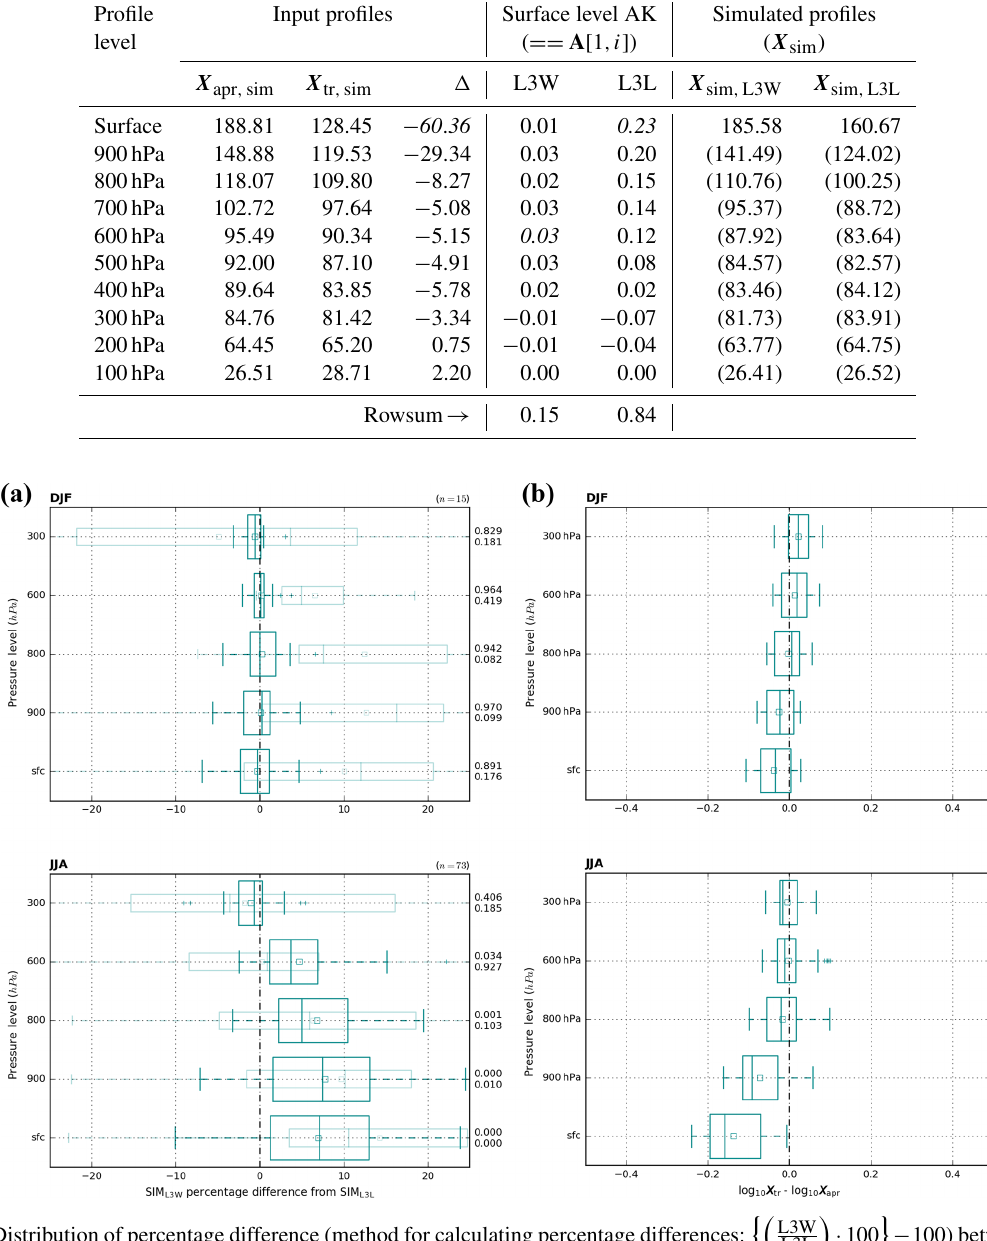
Figure 5. (a) Distribution of percentage difference (method for calculating percentage differences: temporally coincident VMR retrievals in L3W (SIM L3W ) and L3L (SIM L3L ). Squares represent mean differences. The p value associated with each mean difference (from a two-tailed Student t test) is given on the right-hand-side y axis (top value shows (cid:49) SIM; bottom value shows (cid:49) RET). Plus symbols represent outliers (outliers defined as above (below) percentile 75 ( 25 ) + ( − ) 1 . 5 · interquartile range). Faint shading shows the corresponding (cid:49) RET boxplots for comparison. Note that the sample size is different to Fig. 2 owing to the CAMSRA data used as the X tr , sim profile only covering a subset of the MOPITT years (2003–2016 vs. 2001–2017 in Fig. 2). The (cid:49) RET boxplots overlaid cover this shortened period. (b) Distribution of the log 10 X tr , sim − log 10 X apr , sim values calculated during the simulation of retrieved profiles (see Eq. 2) in DJF (top subpanel) and JJA (bottom